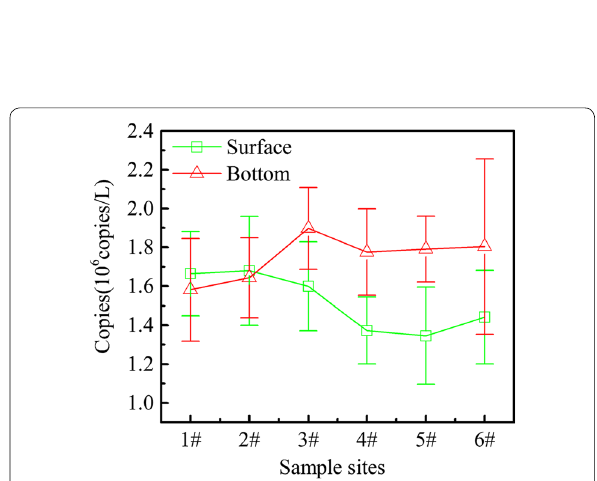
Fig. 8 mic distribution in surface and bottom of different sites in